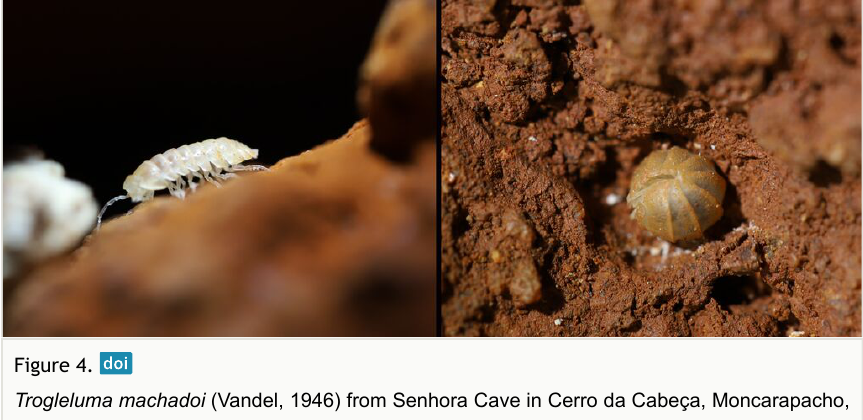
Figure 4. Trogleluma machadoi (Vandel, 1946) from Senhora Cave in Cerro da Cabeça, Moncarapacho,